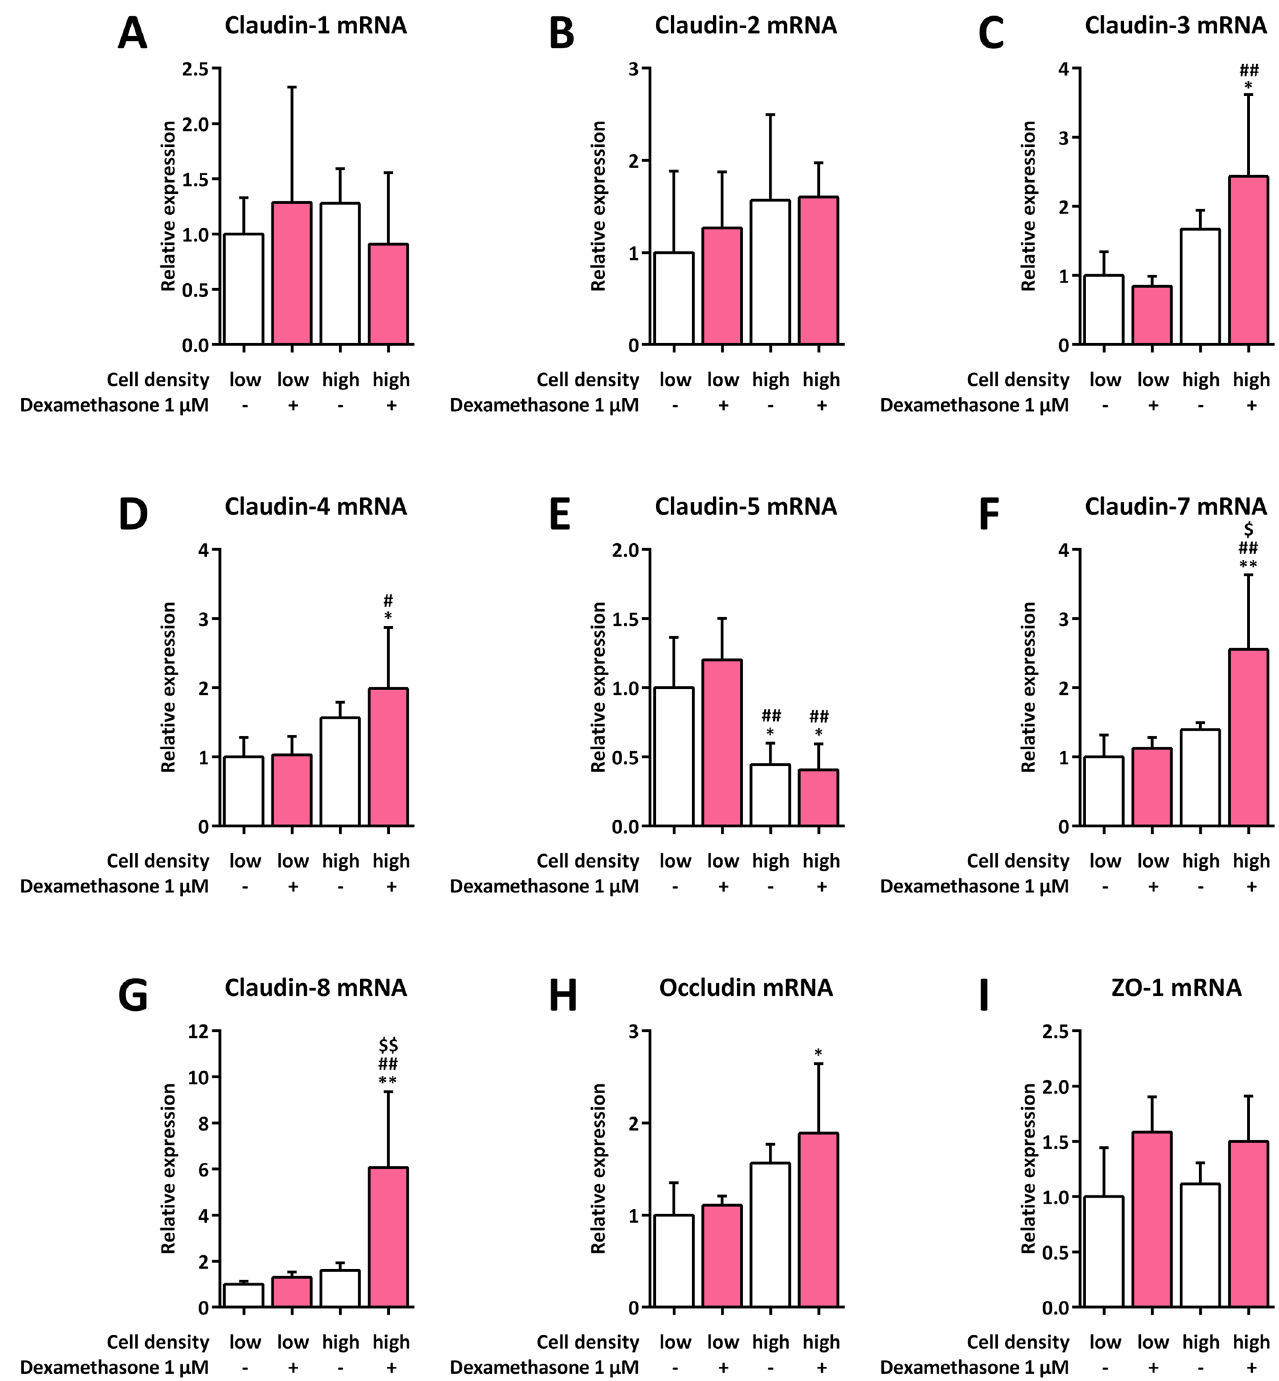
Fig 5. Influence of cell density on mRNA expression of tight junction or tight junction-related proteins in H441 cells. H441 cells were seededat low (1 × 10 4 cells per cm 2 ) and high (7.5 × 10 4 cells per cm 2 ) densitiesand either left untreated or incubatedwith 1 μ M dexamethasone for 24 h. qPCR of claudin-1( A ), claudin-2( B ), claudin-3( C ), claudin-4 ( D ), claudin-5( E ), claudin-7( F ), claudin-8( G ), occludin( H ), and ZO-1 mRNA ( I ) was performed,mRNA levels were normalized to those of GAPDH, and fold differences comparedto 1 × 10 4 untreatedcells per cm 2 were calculated. Means +SD of n = 5 experiments are shown. * p < 0.05 and ** p < 0.01 comparedto 1 × 10 4 untreated cells per cm 2 , # p < 0.05 and ## p < 0.01 comparedto 1 × 10 4 dexamethasone-treatedcells per cm 2 , $ p < 0.05 and $ $ p < 0.01 comparedto 7.5 × 10 4 untreatedcells per cm 2 .